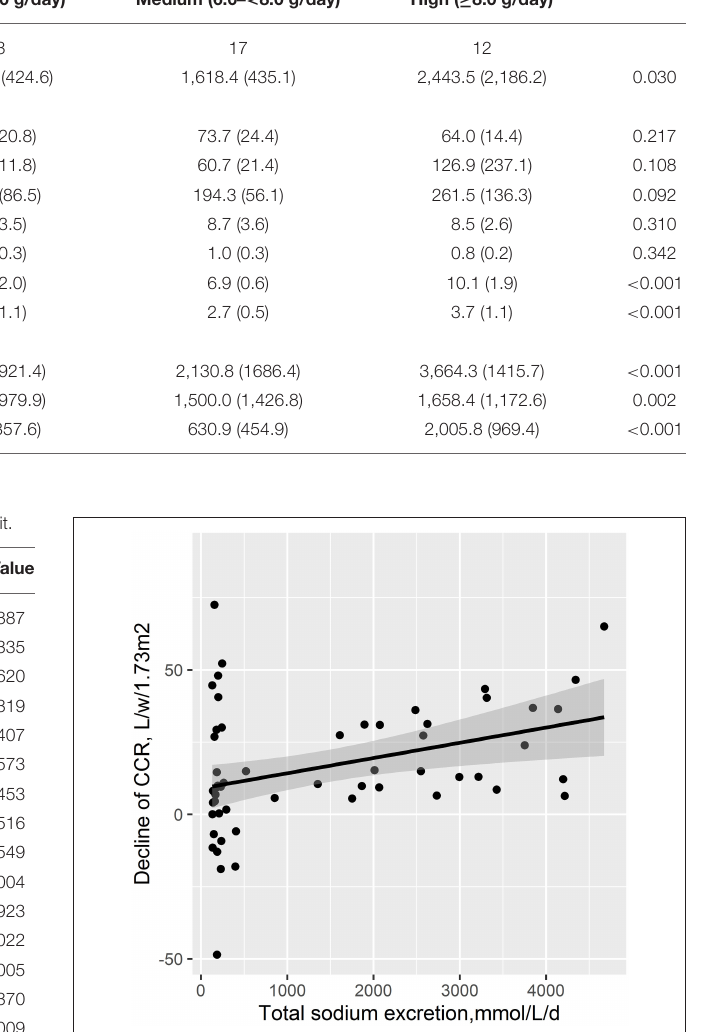
FIGURE 1 | Decline of the residual renal CCR in different groups of salt